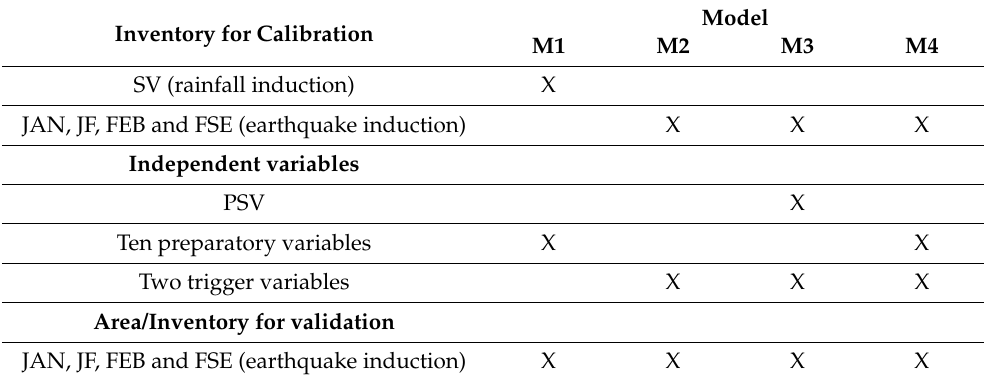
Table 5. Inventories and independent variables used in M1, M2, M3 and M4